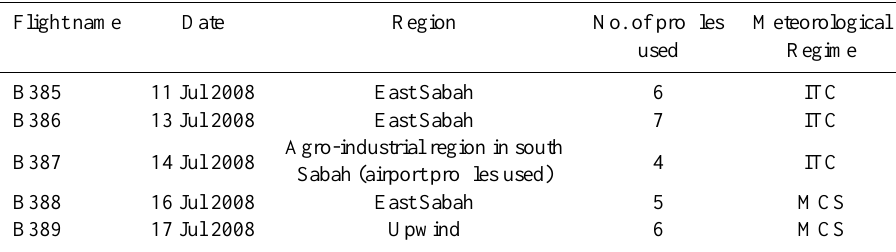
Table 1. Details of flights performed.